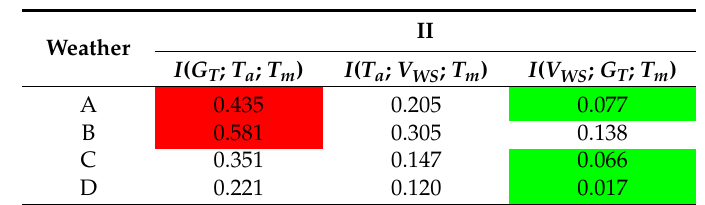
lowest values are in green